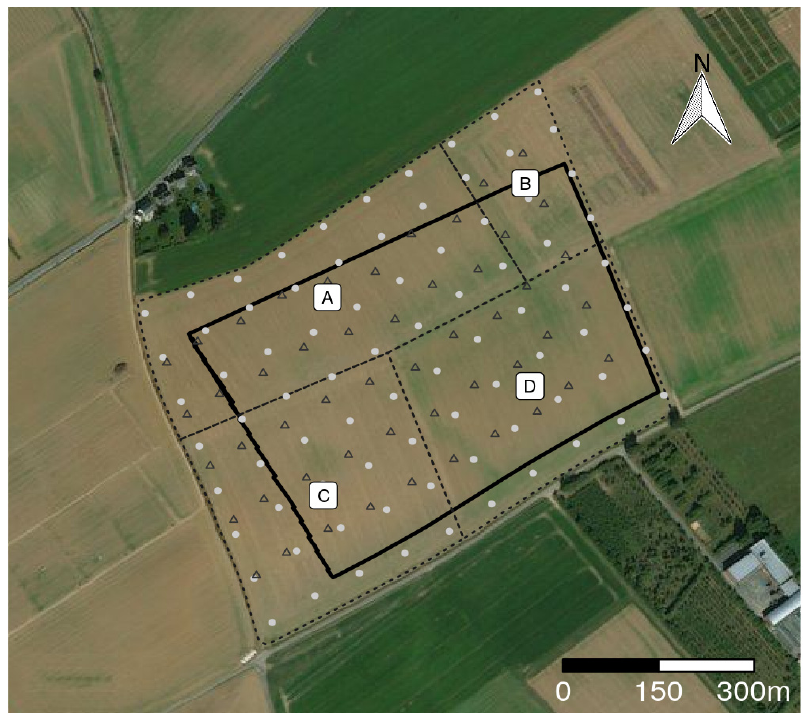
Figure 1. RGB image of the study site (Bing Aerial ® ). Dashed lines delineate the former field layout (parcels A, B, C, and D) before merging in spring 2017 to make up the 17 ha field. The black continuous line delineates the study area, defined by applying an inner buffer of 5 m, deleting the headlands and keeping only the common area between the three unmanned aerial vehicle (UAV) images captured during the 2018 winter wheat growing season. Dots indicate locations of soil samples and triangles indicate locations of plant area index (PAI) measurements (May 2018).